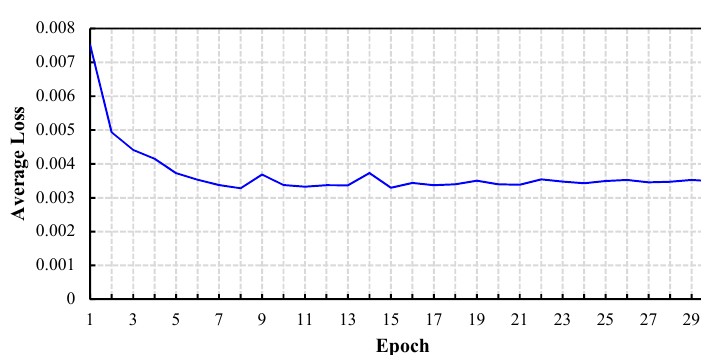
Figure 10. Loss value of the model training process.